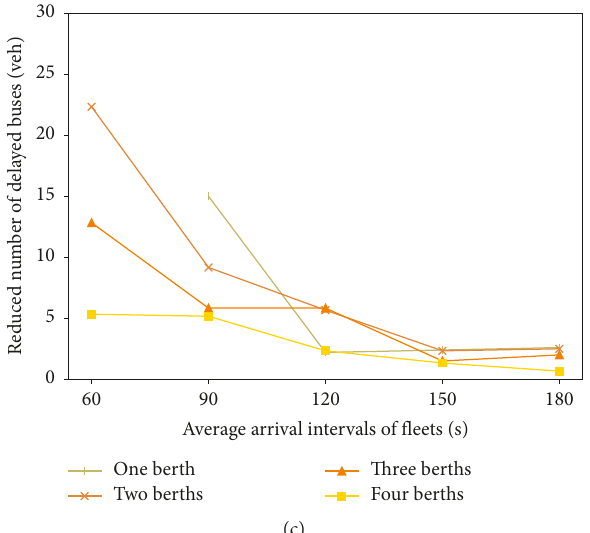
Figure 13: Impacts of bus volumes and berth numbers: (a) on weighted bus delays, (b) on average schedule delays, and (c) on numbers of delayed